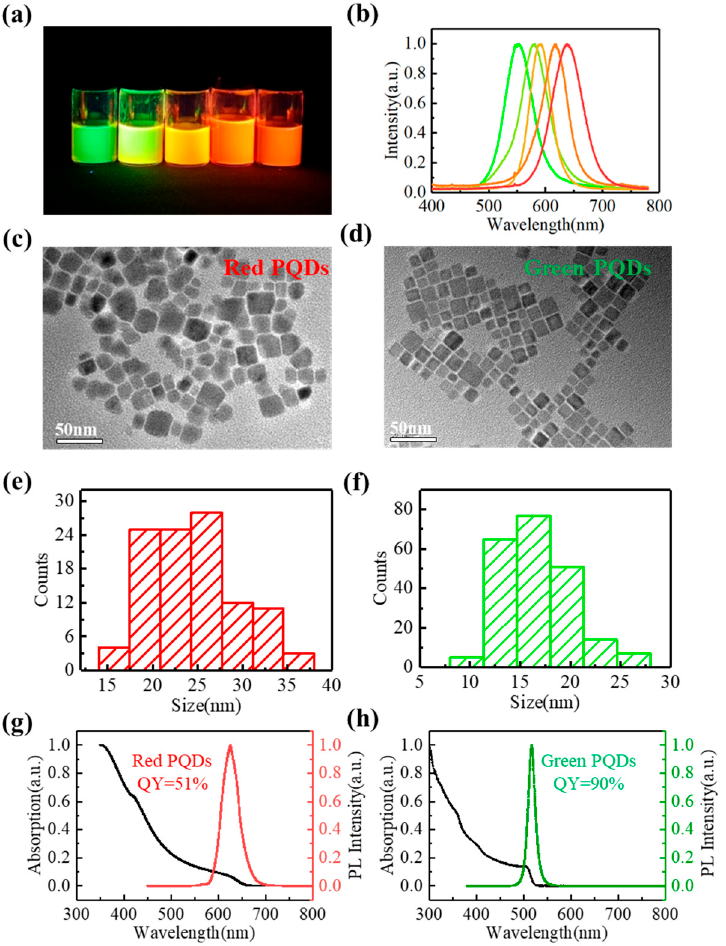
Figure 3. The ( a ) solution and ( b ) emission lines of different color PQDs. TEM image of ( c ) red and ( d ) green PQDs. Particle size distribution of ( e ) red and (f ) green PQDs. Spectral curves of ( g ) red and ( h ) green PQDs.